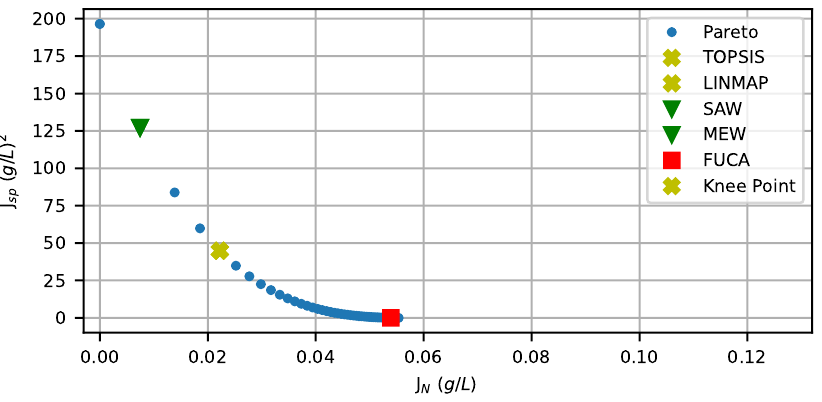
Figure 3. Pareto front for free nutrition strategies, optimal solutions selected by MCDM algorithms and knee point. Points corresponding to α = 0 and α = 1 are